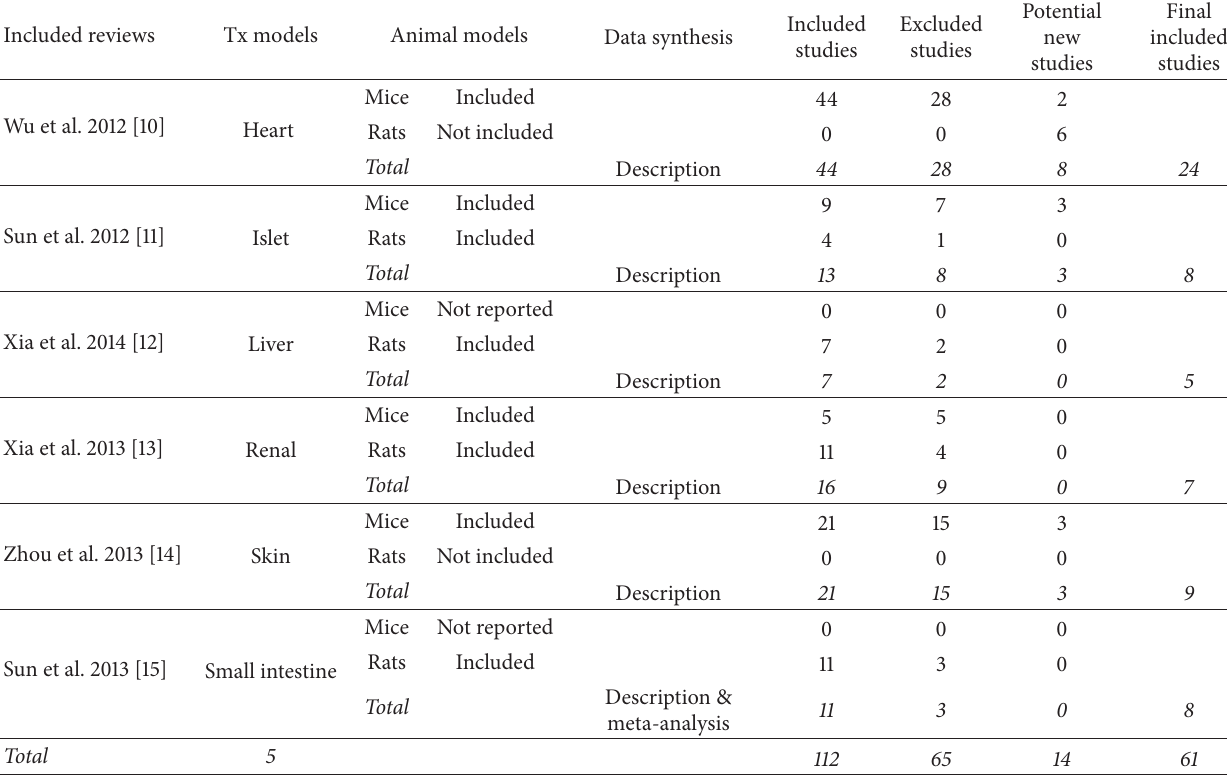
Table 1: Characteristics of included systematic reviews.